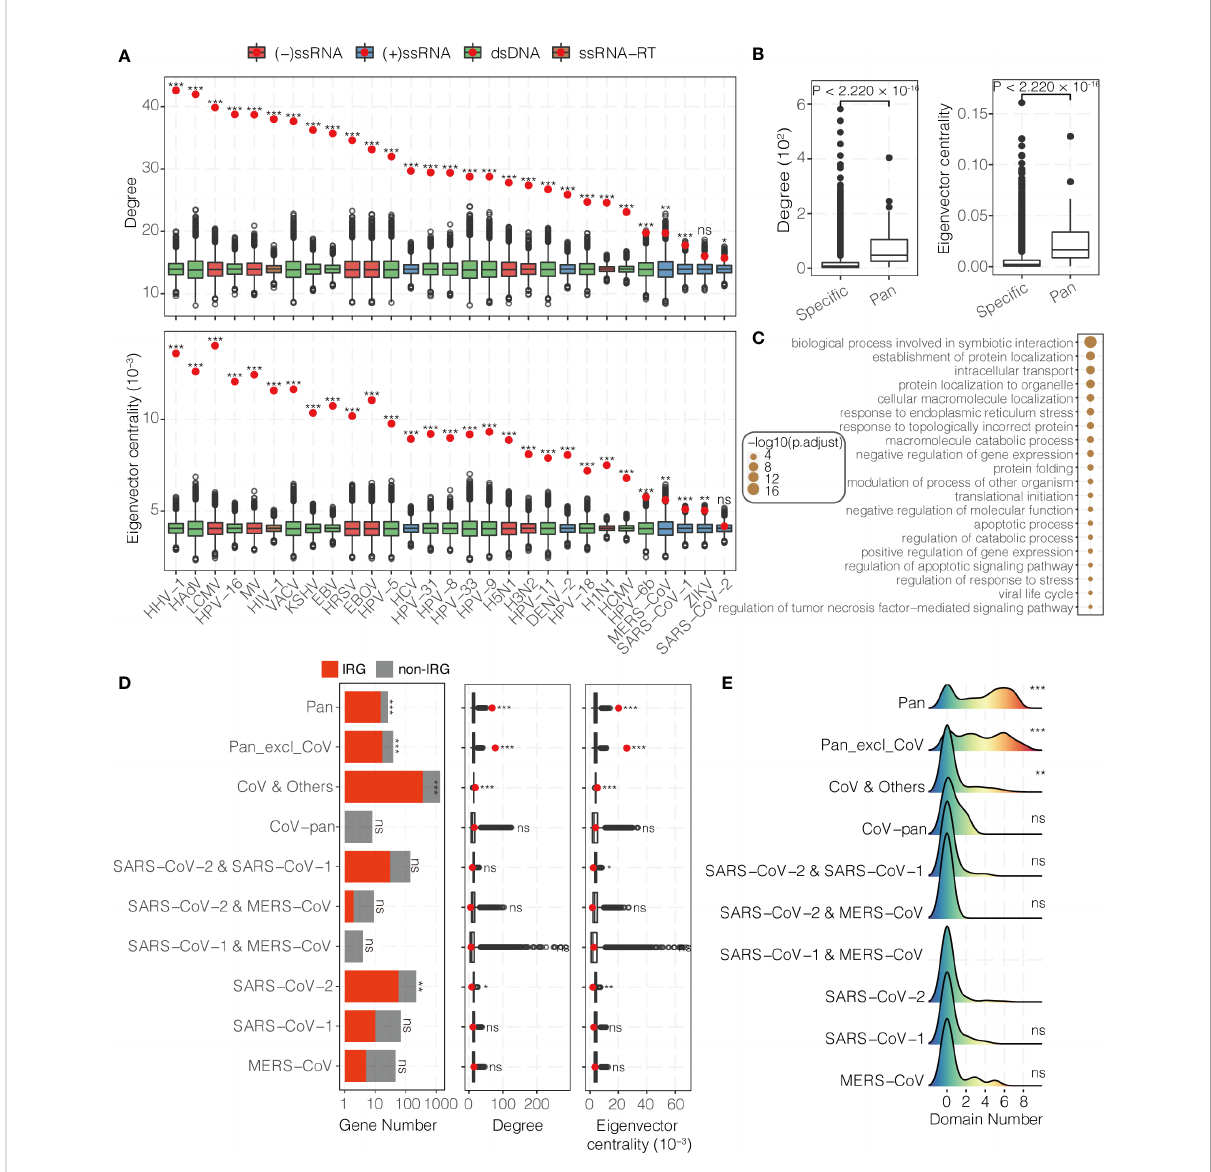
FIGURE 3 Topological and functional characteristics of virally-targeted human genes. (A) Degree (upper) and eigenvector centrality (bottom) of VTGs. The red dots and the corresponding boxes represent the observed values and the simulated distributions using the bootstrapping method, respectively. DENV-2, Dengue virus 2; EBOV, Ebola virus; EBV, Epstein-Barr virus; HAdV, Human adenovirus C; HCMV, Human cytomegalovirus; HCV, Hepatitis C virus; HHV-1, Human herpesvirus 1; HIV-1, Human immunode fi ciency virus 1; HPV-5, HPV-6b, HPV-8, HPV-9, HPV-11, HPV- 16, HPV-18, HPV-31 and HPV-33, Human papillomavirus 5, 6b, 8, 9, 11, 16, 18, 31 and 33; HRSV, Human respiratory syncytial virus; H1N1, H3N2 and H5N1, In fl uenza A H1N1, H3N2 and H5N1 virus; KSHV, Kaposi ’ s sarcoma-associated herpesvirus; LCMV, Lymphocytic choriomeningitis virus; MV, Measles virus; MERS-CoV, Middle East respiratory syndrome coronavirus; SARS-CoV-1, severe acute respiratory syndrome coronavirus 1; SARS-CoV-2, severe acute respiratory syndrome coronavirus 2; VACV, Vaccinia virus; ZIKV, Zika virus. (B) Degree (left) and eigenvector centrality (right) distributions of speci fi c- and pan-viral targets. (C) Functional enrichment analysis of pan-viral targets. (D) Number (left), degree (middle) and eigenvector centrality (right) of three coronaviruses targeted host genes. The red dots and the corresponding boxes represent the observed values and the simulated distributions using the bootstrapping method, respectively. Pan, pan-viral genes targeted by at least one coronavirus; Pan_excl_CoV, pan-viral genes not targeted by coronavirus; CoV & Others, host genes targeted by at least one coronavirus and at least one other virus; CoV-pan, host genes only targeted by all three coronaviruses; SARS-CoV-2 & SARS-CoV-1, SARS-CoV-2 & MERS-CoV and SARS- CoV-1 & MERS-CoV, three coronaviral pairs of targeted host genes; SARS-CoV-2, SARS-CoV-1 and MERS-CoV, speci fi cally targeted host genes for each coronavirus. (E) Functional domain number of three coronaviruses targeted host genes. *** P -value < 0.001, ** P -value < 0.01, * P -value < 0.05, ns, not signi fi cantly